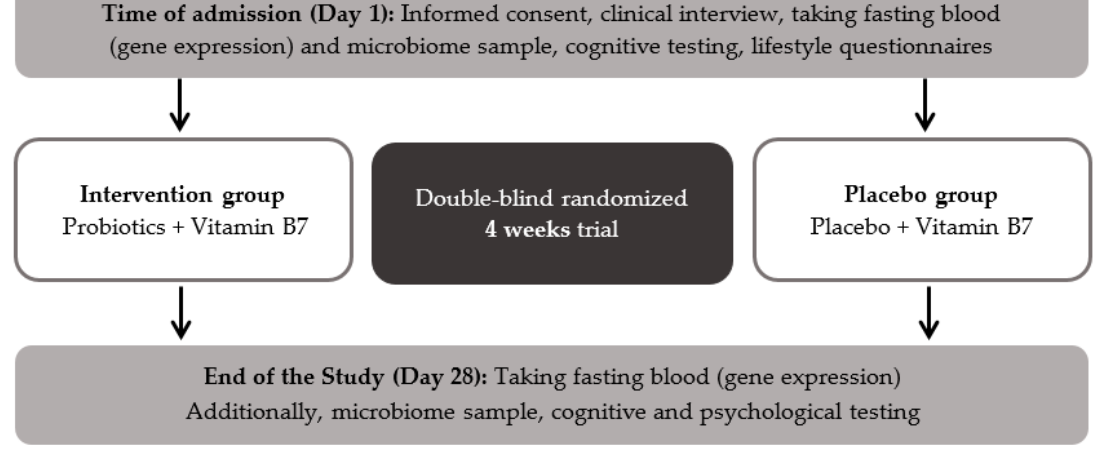
Figure 2. Workflow of the PROVIT study.